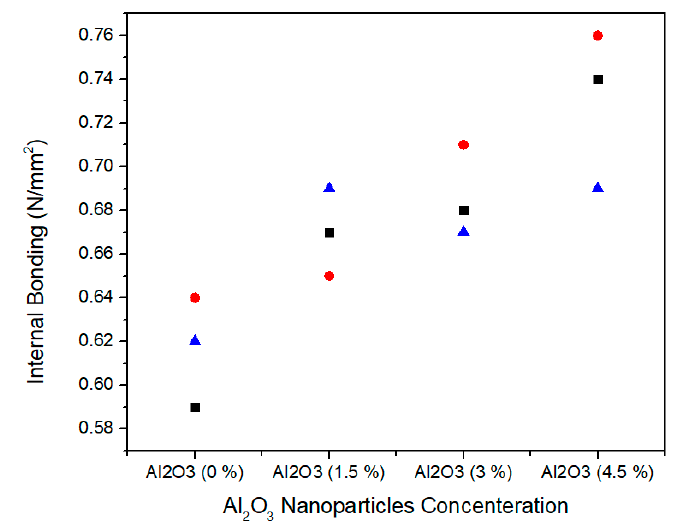
Figure 12. Numerical values of internal bonding of various treatments of alumina nanoparticles.